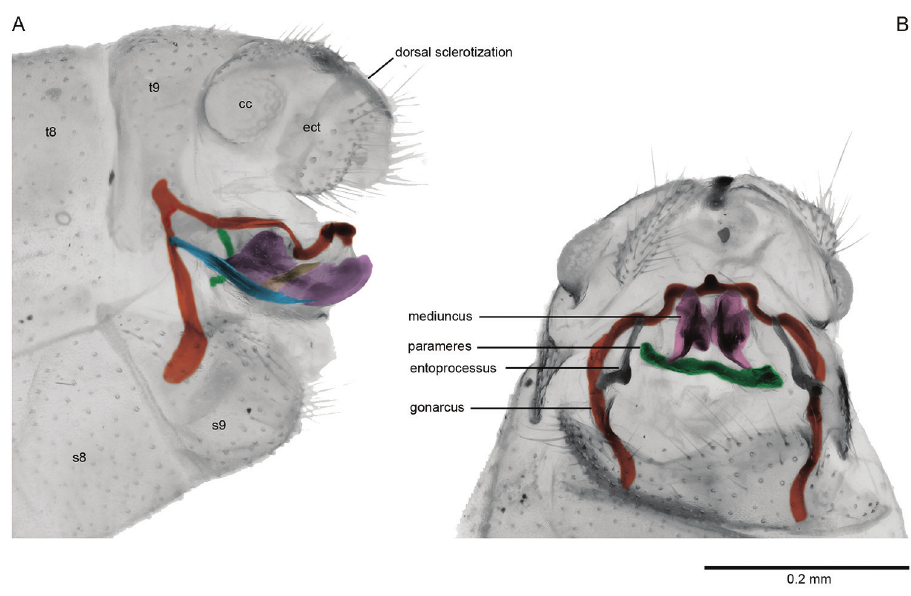
Figure 4. Male genitalia of Spilosmylus spilopteryx sp. n.: A lateral view B ventral view. Abbreviations: t8, tergite 8; s8, sternite 8; t9, tergite 9; st9, sternite 9; ect, ectoproct; cc, callus